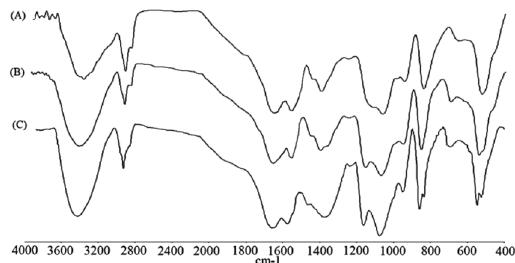
Figure 6. FTIR absorption spectra of BSs produced by strain SHU1593 in MRS-Lac ( A ), date syrup ( B ) and molasses ( C )